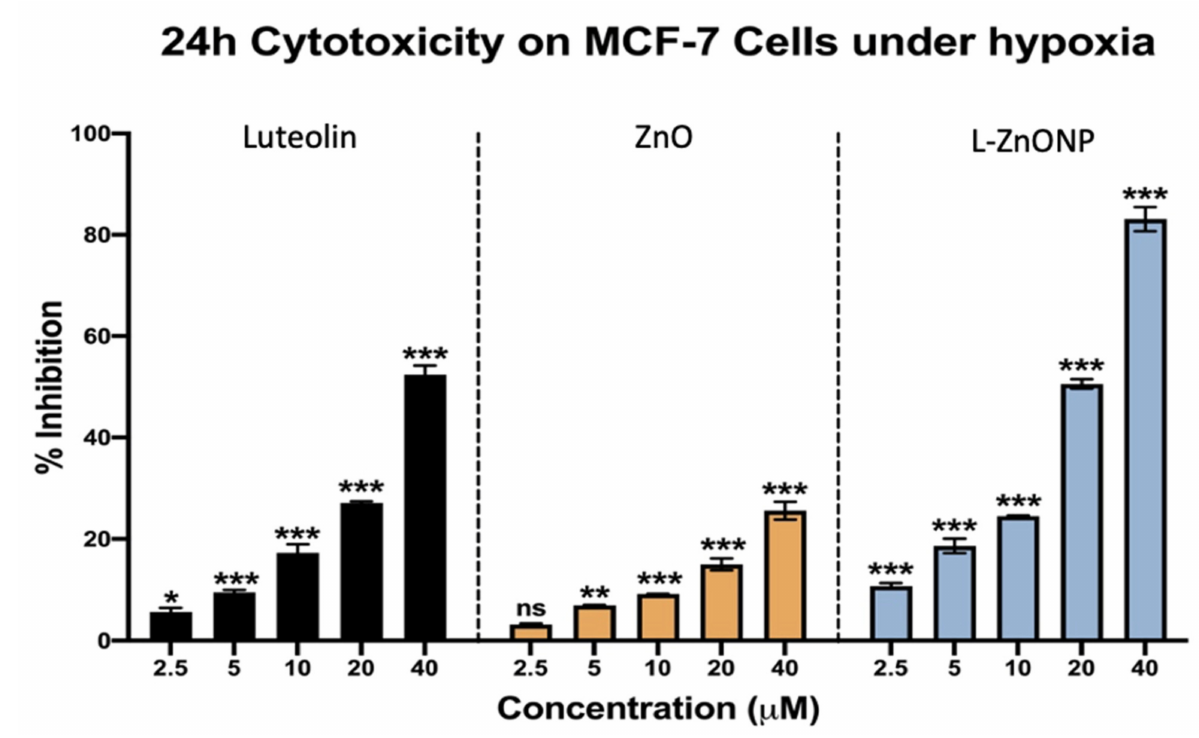
Figure 8. Anticancer activity of luteolin, ZnO, and L-ZnONPs on MCF-7 cell lines. * p < 0.033, ** p < 0.002, *** p < 0.001, ns = not significant.